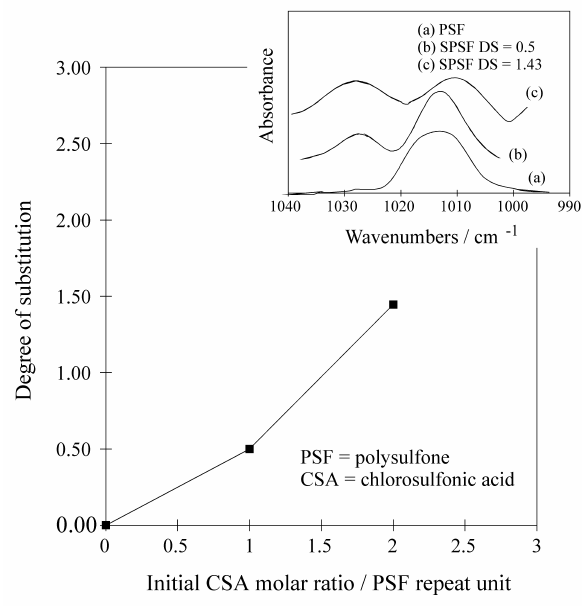
Figure 3. of polysulfone. Top of the figure: deconvolution of FTIR spectra used to determine the degree of sulfonation.